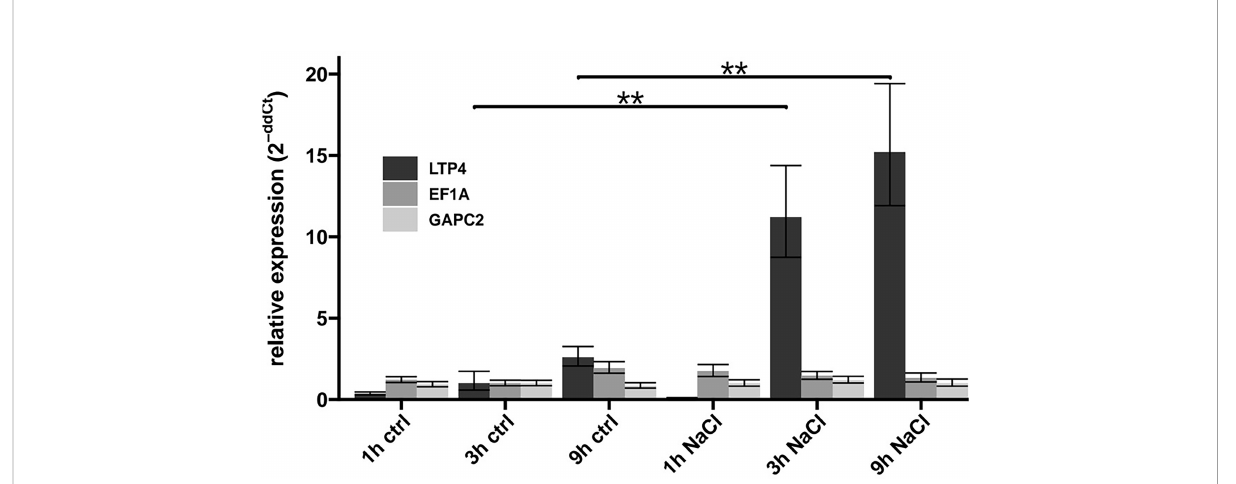
FIGURE 2 Changes in transcript levels upon exposure to NaCl. After growth on solid MS medium for 7 DAS, Col-0 plants were transferred to control medium (ctrl) or to medium containing 100 mM NaCl (NaCl). After different periods of the indicated treatment, RNA was isolated and the transcript levels of LTP4 and reference genes ( EF1A , GAPC2 , ACT2 ) quanti fi ed by RT-qPCR. The depicted relative expression was normalised to the level of ACT2 transcript in Col-0. The bars represent the mean relative expression of three technical replicates and error bars represent SD. The relative expression of LTP4 was compared between control and NaCl treated condition of the same timepoints using Wilcoxon´s signed- rank test indicated by brackets (**, p ≤ 0.01).